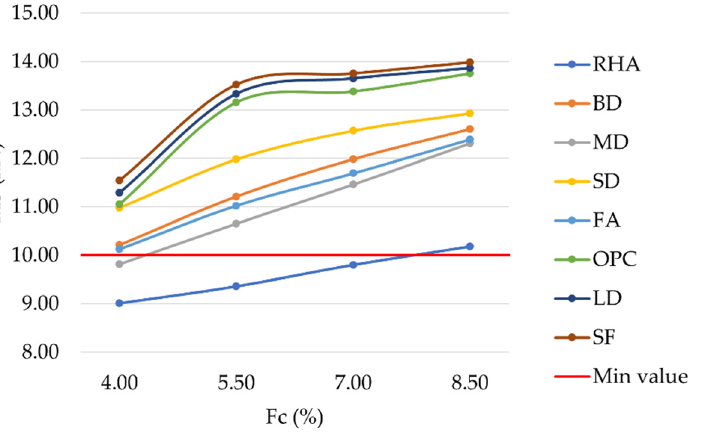
Figure 6. Voids filled with bitumen vs. filler content for mixtures prepared with conventional and waste fillers.